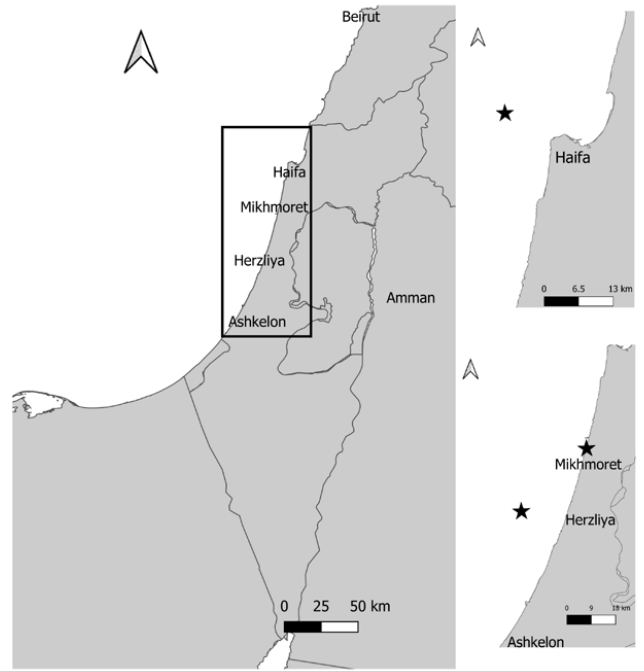
Figure 1. Map of Agelas oroides sampling and transplantation points (marked by asterisks).